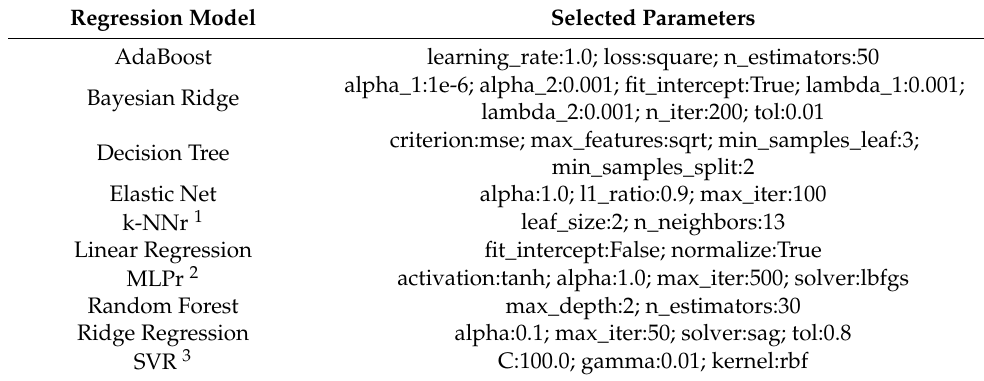
Table 2. Selected parameters by grid